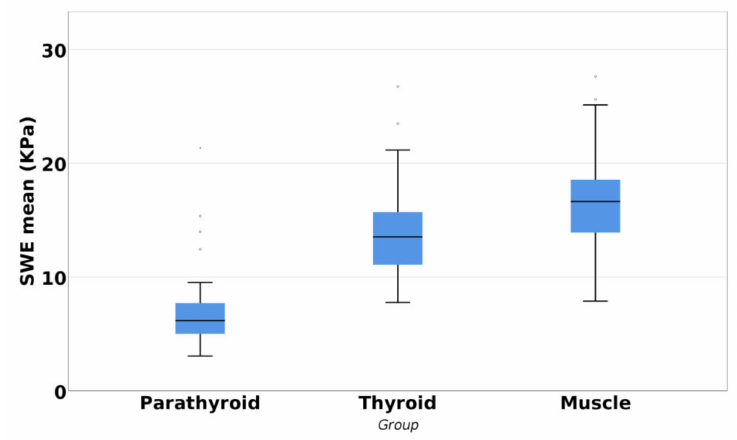
Figure 5. Differences between parathyroid, thyroid, and muscle tissue. The ROC curve for parathyroid tissue reported and thyroid and muscle tissue have AUC 0.953; 95% CI (0.928; 0.997); p < 0.001 (Figure 6). The determined cutoff value for parathyroid tissue was established below 9.58 kPa, with a sensitivity of 95.6%, a specificity of 94.1%, accuracy of 94.6%, negative predictive value of 94.4%, and positive predictive value of 97%.